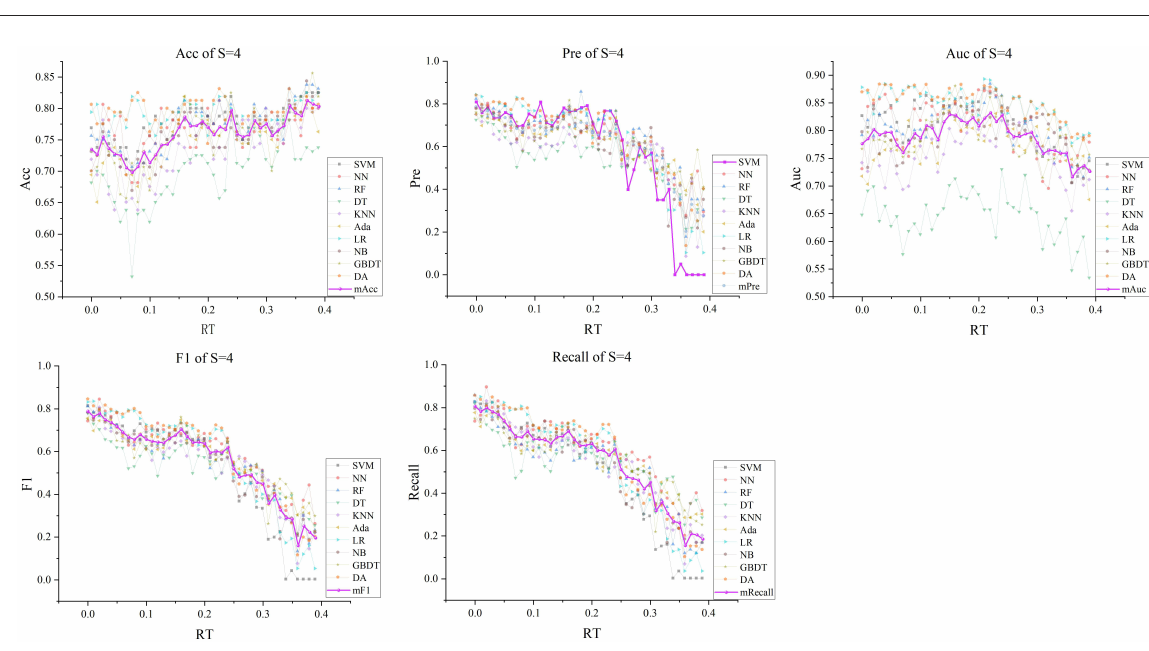
found, thus obtaining accurate classification results. Besides, DA, RF, NB, LR, and NN also achieved satisfactory